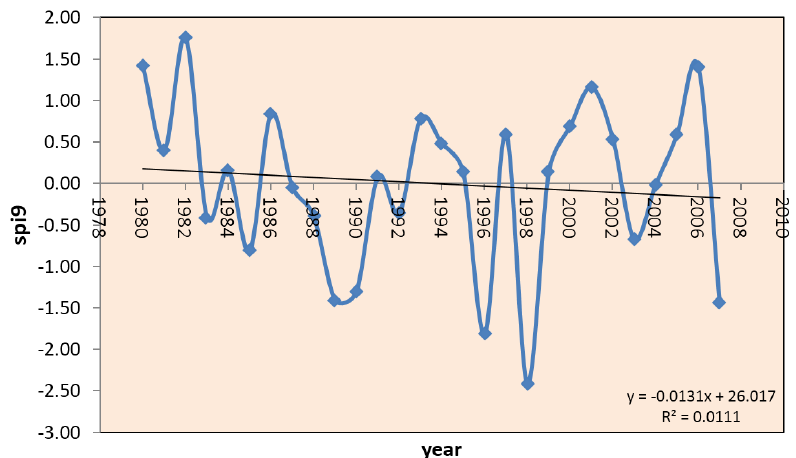
Figure 4. Mean annual rainfall (1980–2007) in the Neuquén River basin.